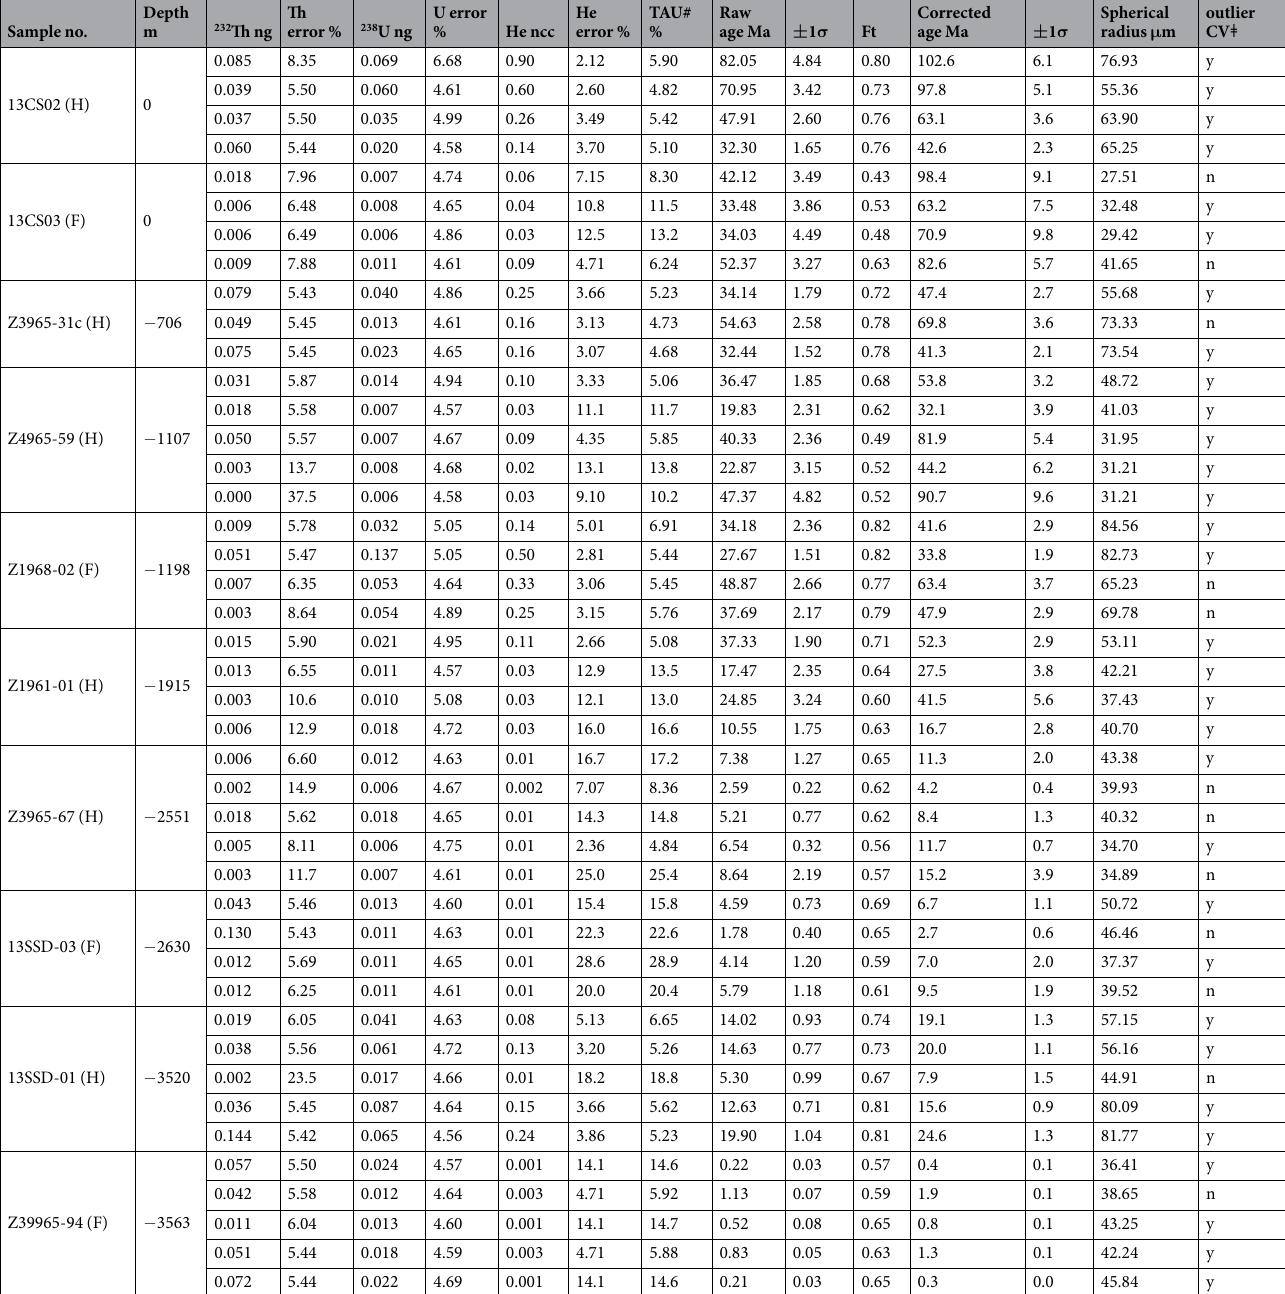
Table 4. (U-Th)/He analytical results for apatite of the Sanshandao gold deposit * Represents concentration of the element in femtomole (Th, U in fmol = the analyzed weight in ng/atomic weight (232 or 238 g/mol) × 10 6 , He in fmol = the analyzed volume in ncc/molar volume for ideal gases (22.4 L/mol) × 10 3 /Ft. ** Represents weighted average age. ǂ Represents outlier detection by the Chauvenet’s criterion; and “n” indicates outlier and “y” indicates